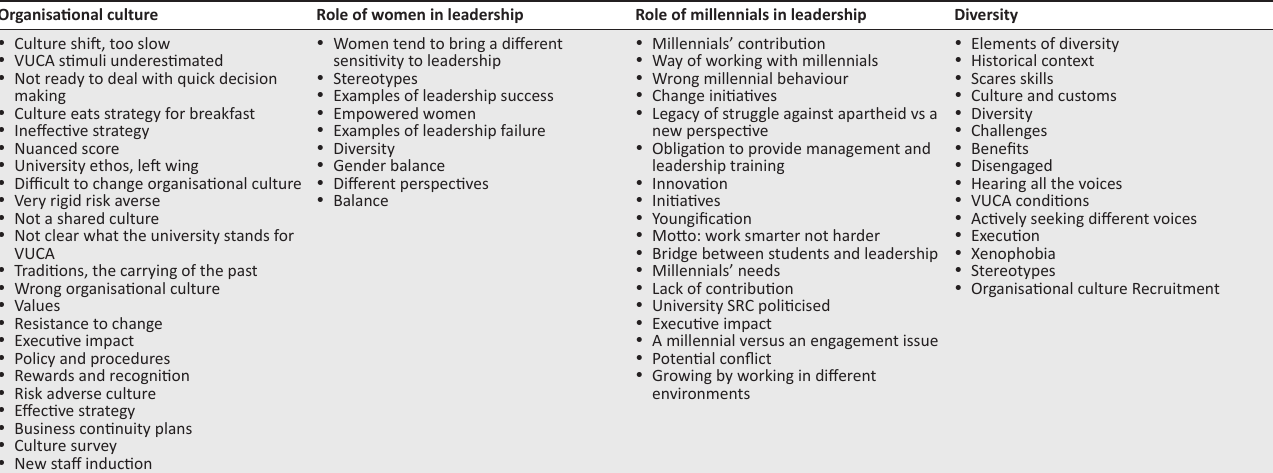
TABLE 1: Four influential factors and their respective coding units impacting leadership effectiveness. Organisational